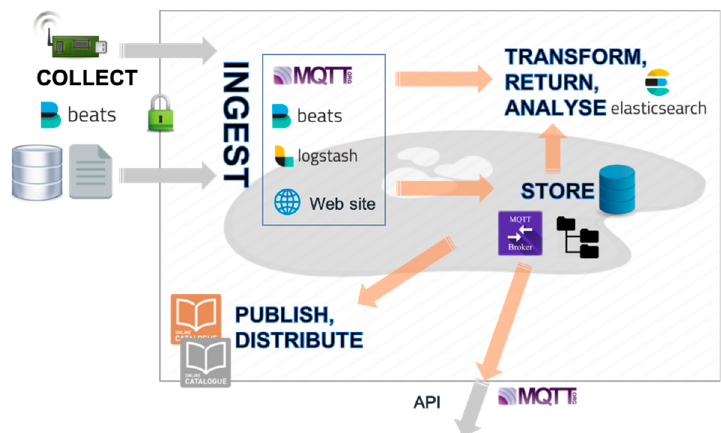
Figure 5. Structure of the data lake implemented in the Université Clermont Auvergne Mésocentre. Beats sends data to Logstash, an open-source data ingestion tool. Data can be retrieved and analyzed using the Elasticsearch engine and visualized on real-time dashboards or exported outside of the data lake using MQTT.